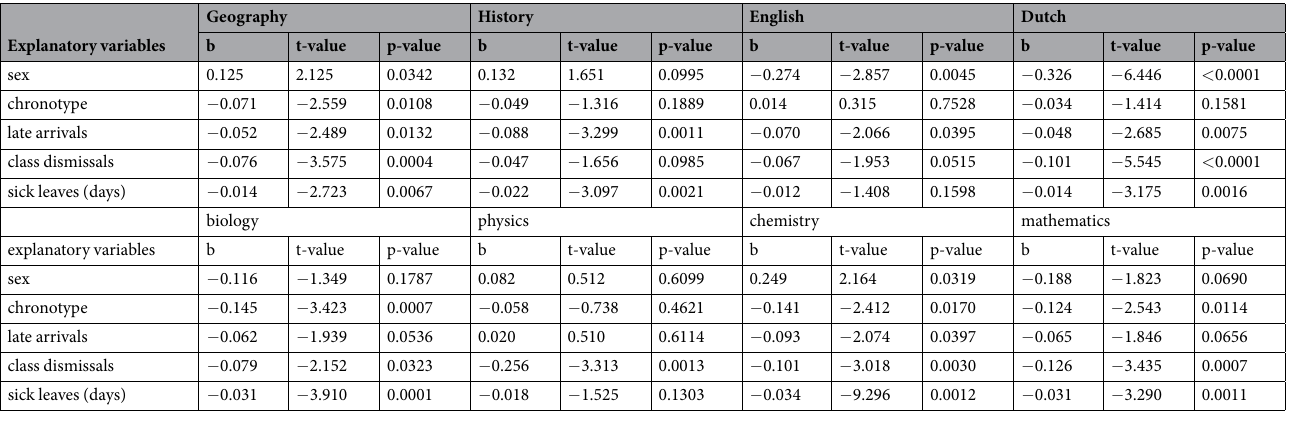
Table 4. Influence of demographic, sleep-related and school attendance variables on school grades by academic subject. The model estimates (b coefficients), the test statistic (t-test), and the p-values associated with each independent variable are reported.